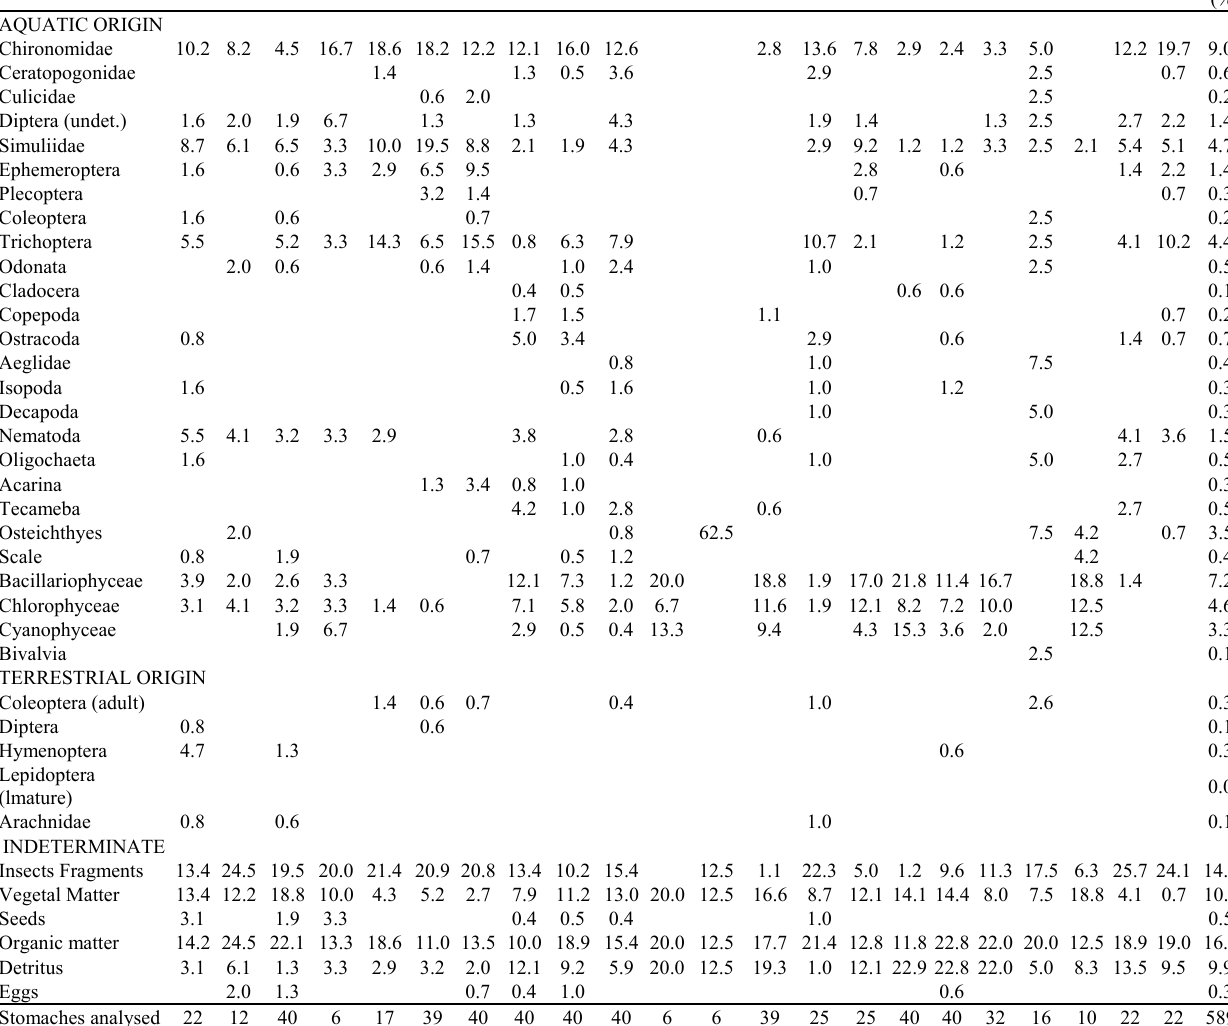
Table 3. Frequency of occurrence (%) of food items of 22 fish species of serra do Japi streams (rainy and dry season). Species codes in Table 2. undet. =